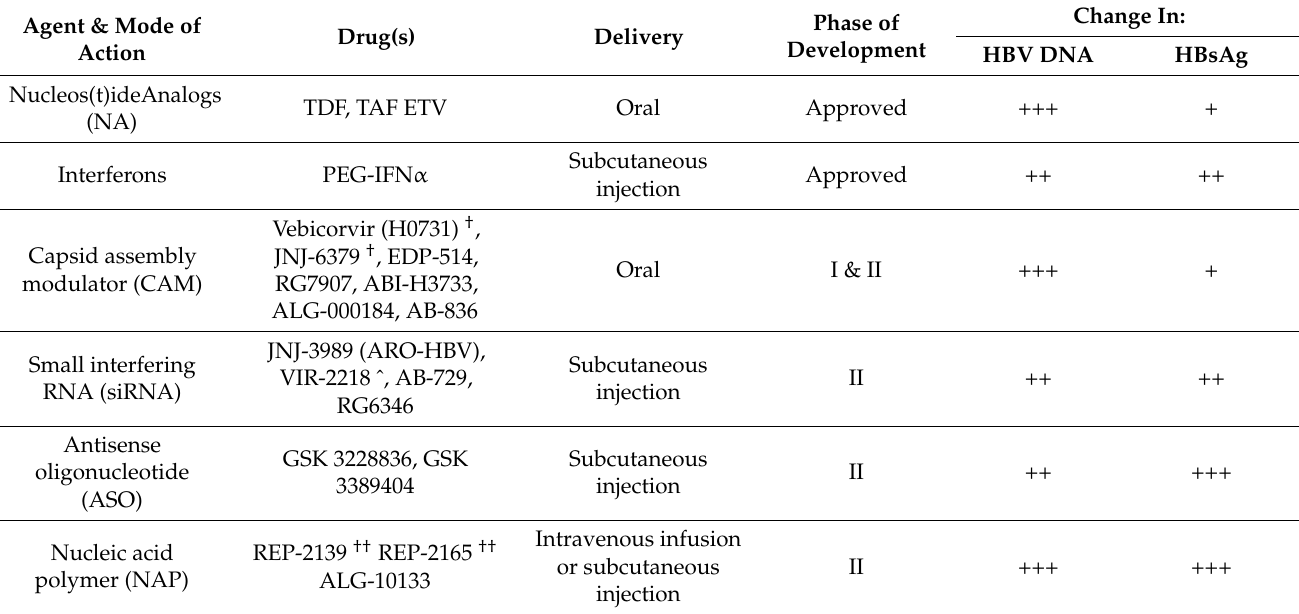
Table 1. Effect of nucleos(t)ide analogs, PEG-IFN, and direct-acting antivirals in clinical development for chronic hepatitis B